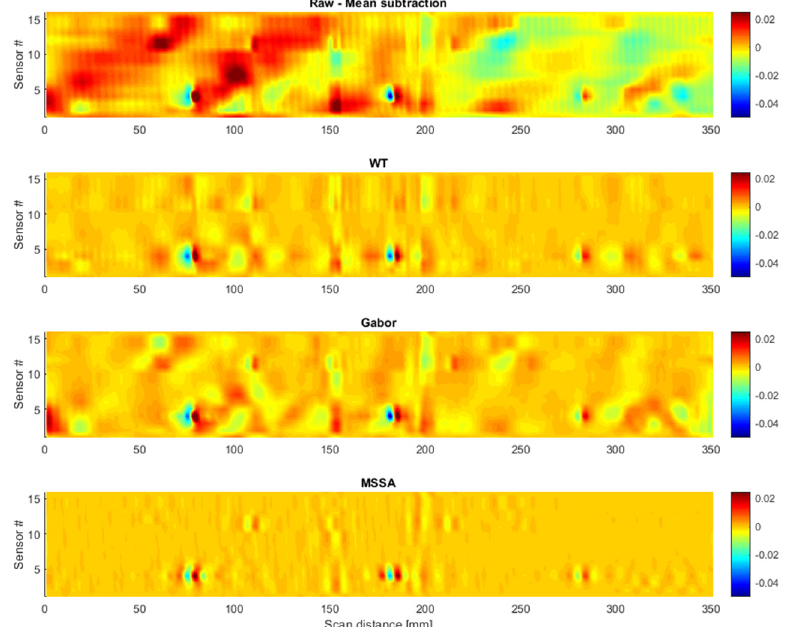
Figure 9. Magnetic scanned signal by the MFLT method with the wavelet, Gabor and proposed MSSA filters.